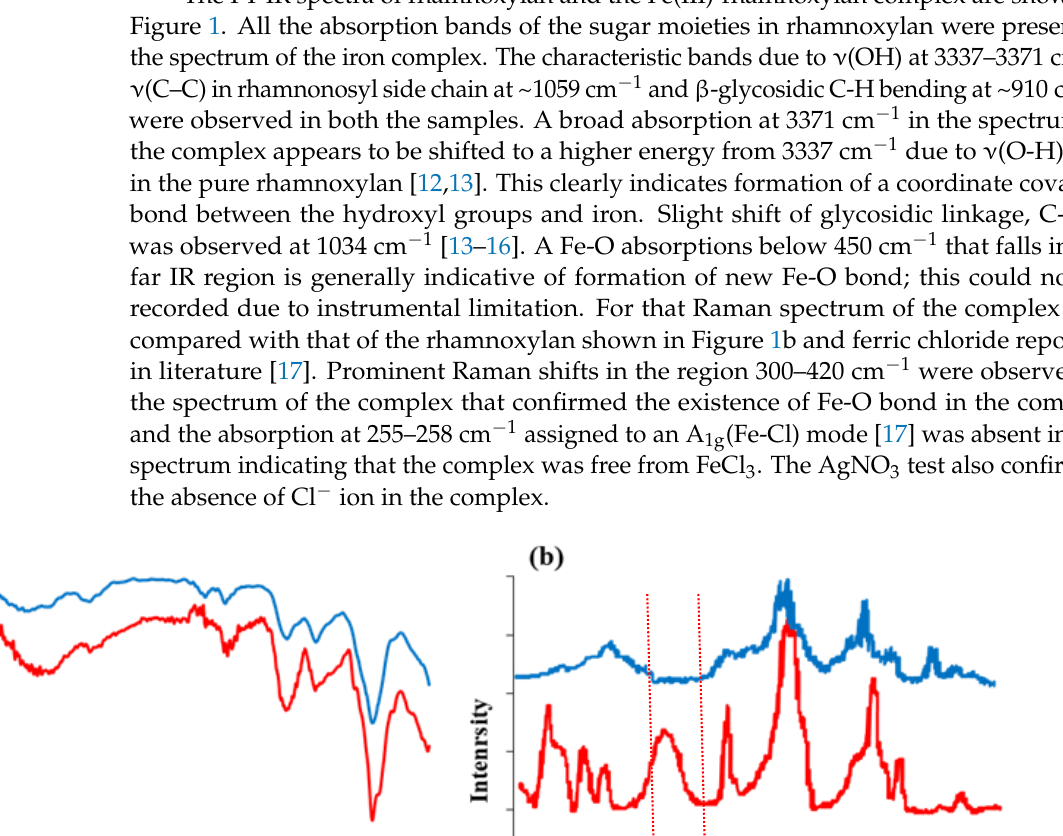
Table 1. Elemental, moisture, monosaccharide and GPC analysis data (% w/w on dry substance ba ‐ sis).